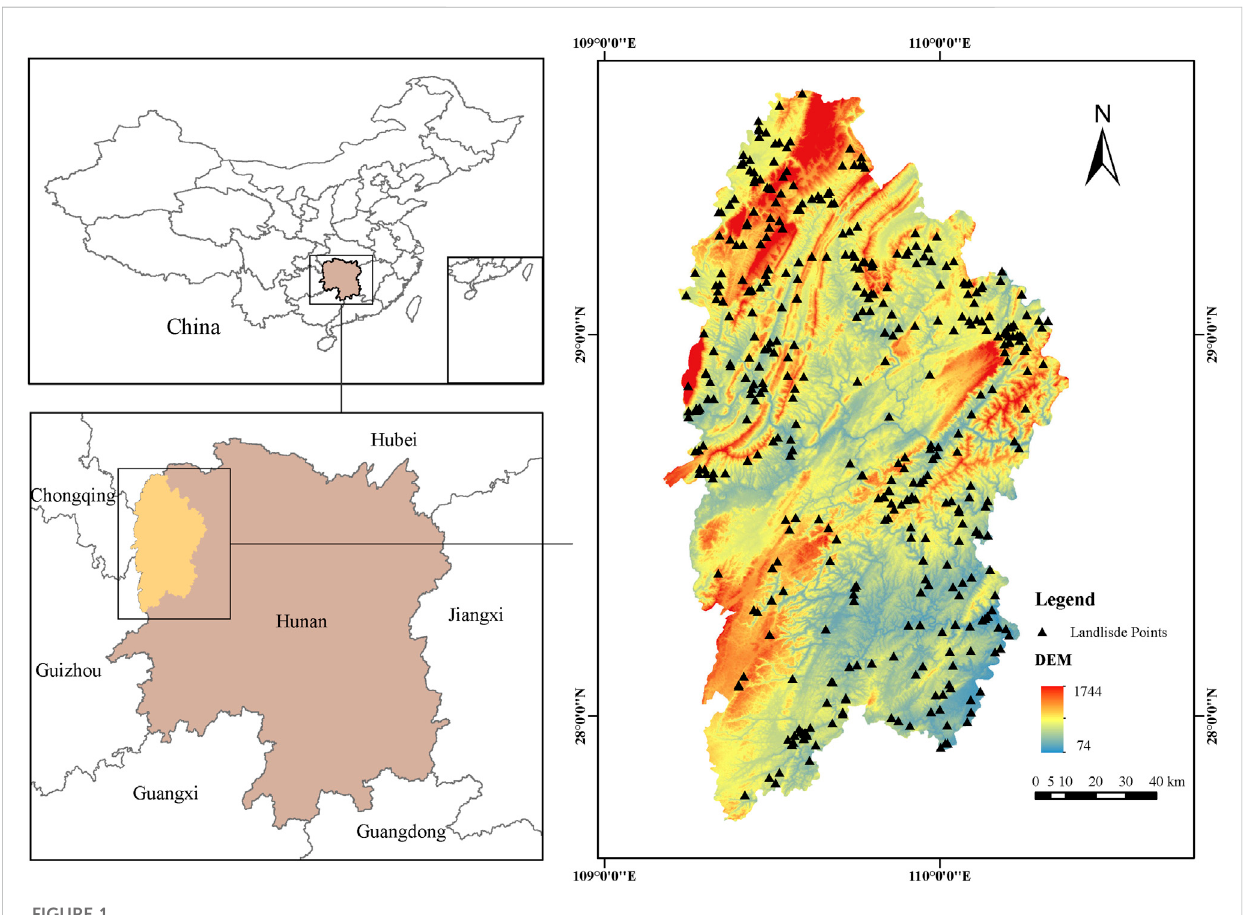
FIGURE 1 The study area and historical landslide hazard